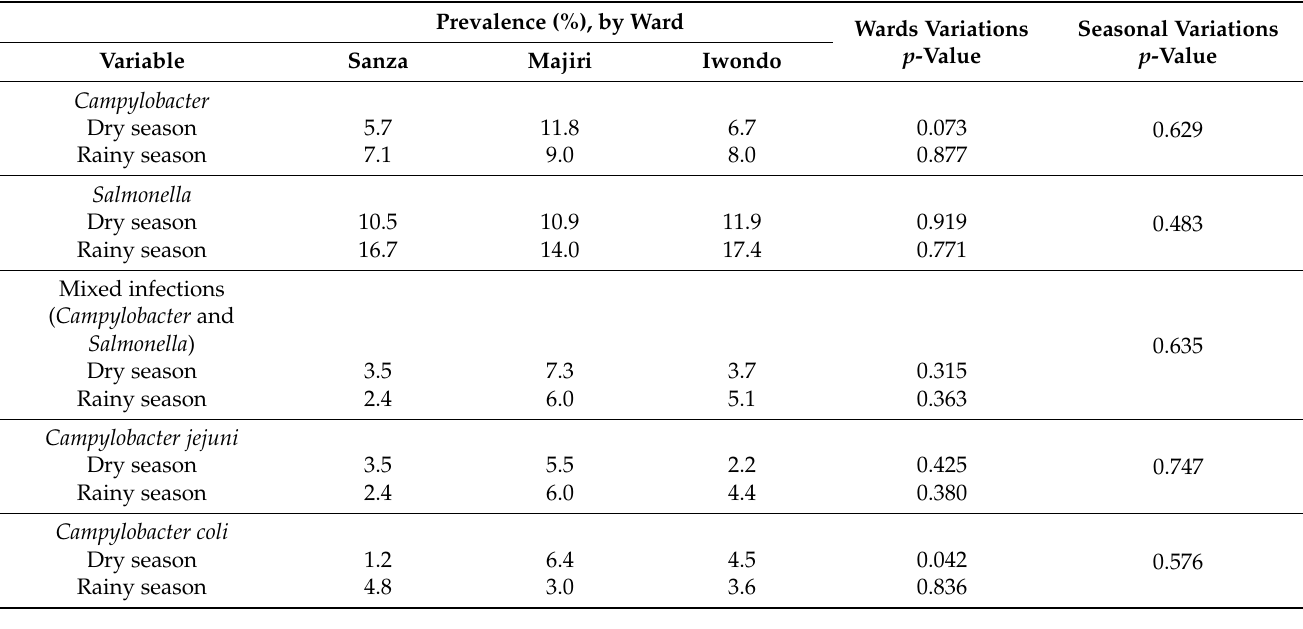
Prevalence (%), by Ward Wards Variations